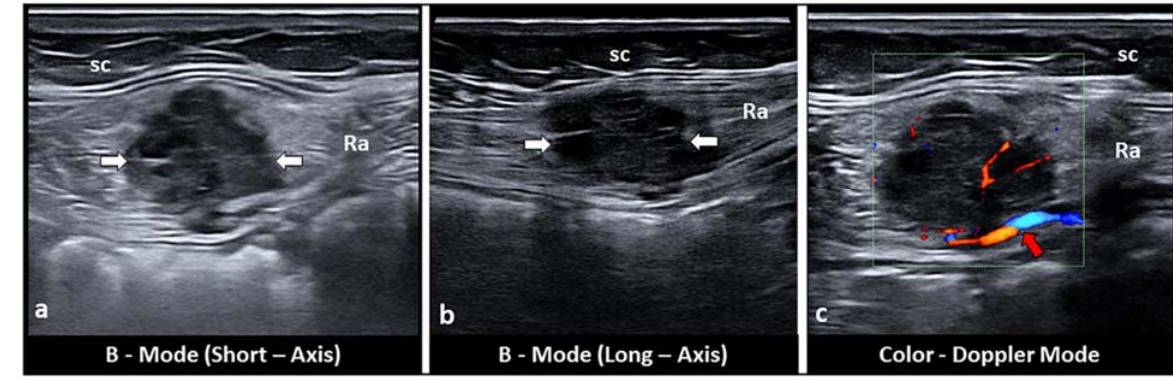
Figure 4. Short ‐ axis ( a ) and long ‐ axis ( b ) sonograms show a hypoechoic, nodular mass (white arrows), located inside the rectus abdominis (Ra) muscle. Of note, fine intralesional, vascular spots (red arrow) are depicted on the color Doppler mode ( c ). sc: subcutaneous tissue.